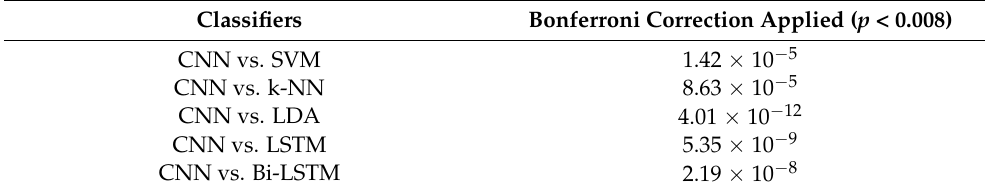
Table 5. Statistical significance between CNN and all other five classifiers